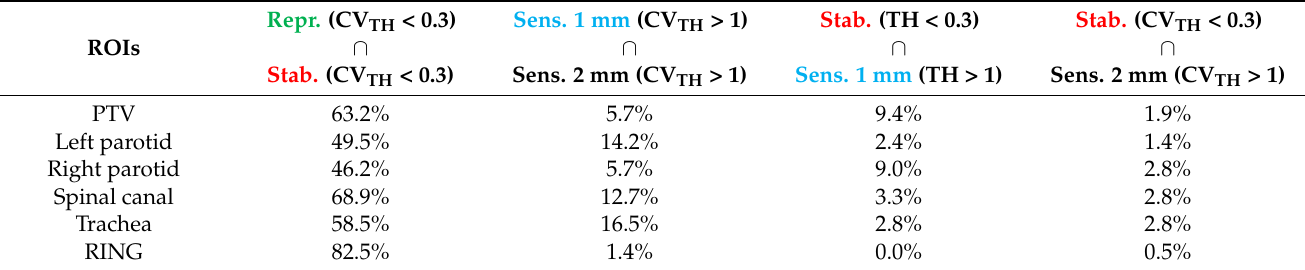
Table 5. List of the percentage of common dosiomic features among different studies and different CV